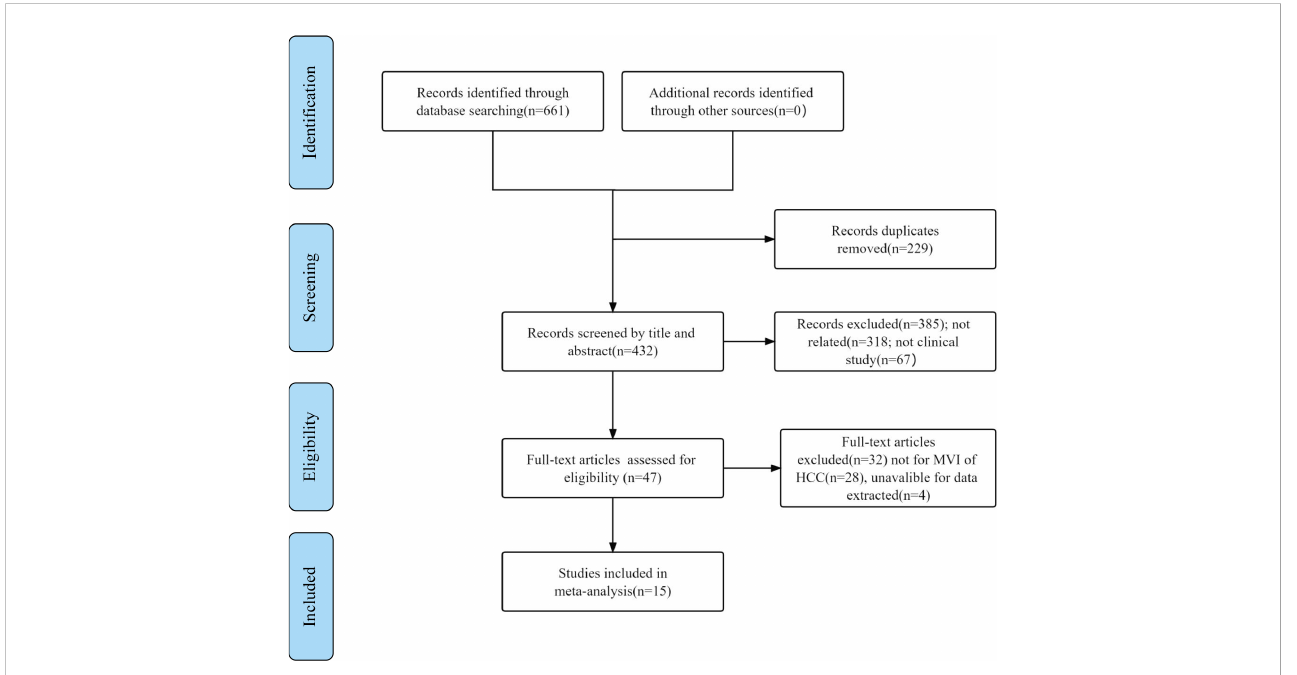
FIGURE 1 Included study selection process for this